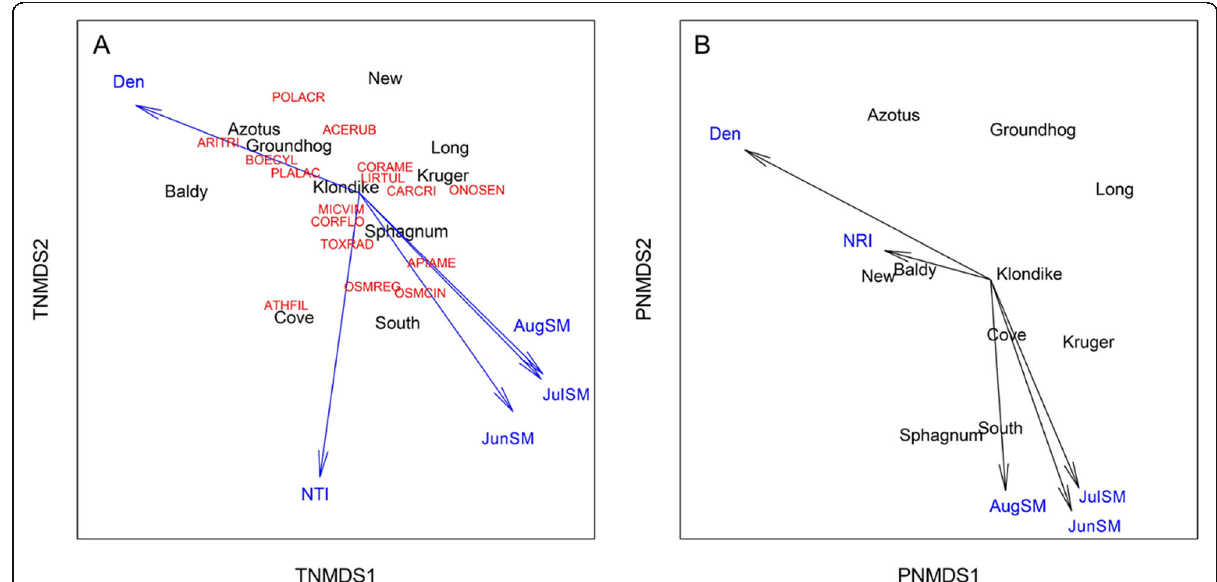
Fig. 3 Two-dimensional a TNMDS and b PNMDS ordinations of ten acid seep springs (names in black text shown at the position of the centroid among 10 plots per spring) based on species abundance data (species in red text; see Table S1 for codes). Only species discussed in